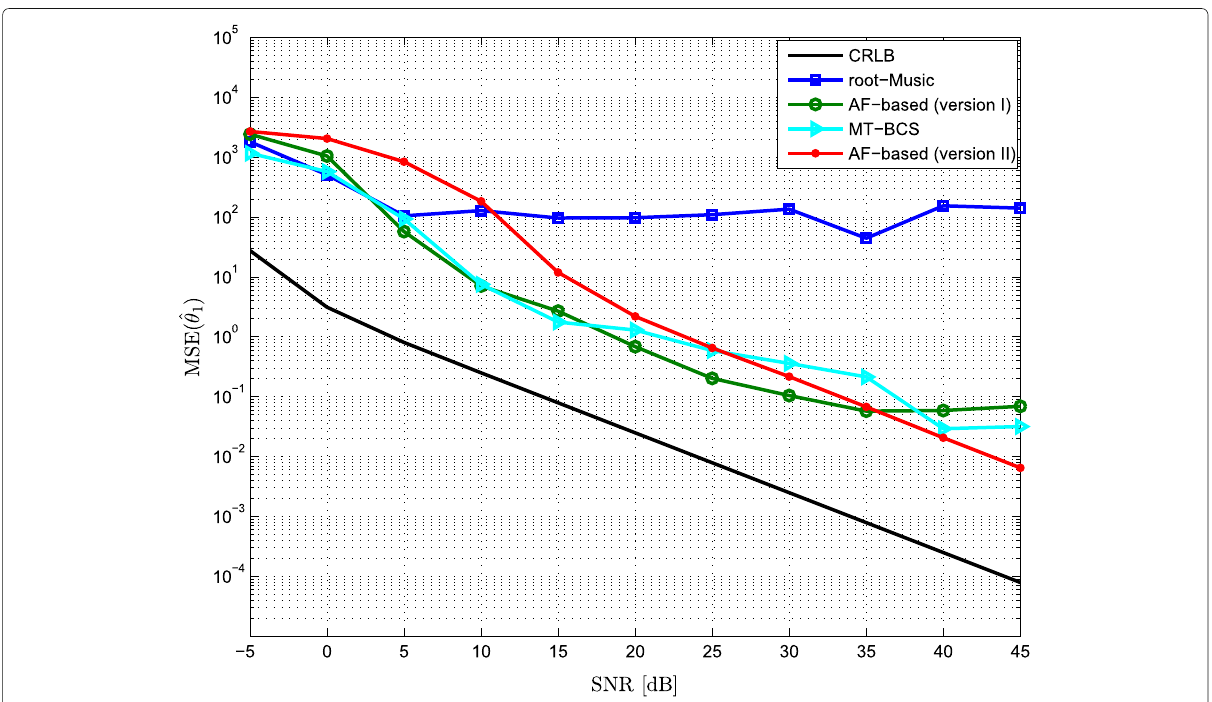
Fig. 2 MSE for the first DOA versus the SNR with K = 2 sources, N = 3 snapshots, θ 1 = 18°, θ 2 = 36°, and N a = 8 antenna elements